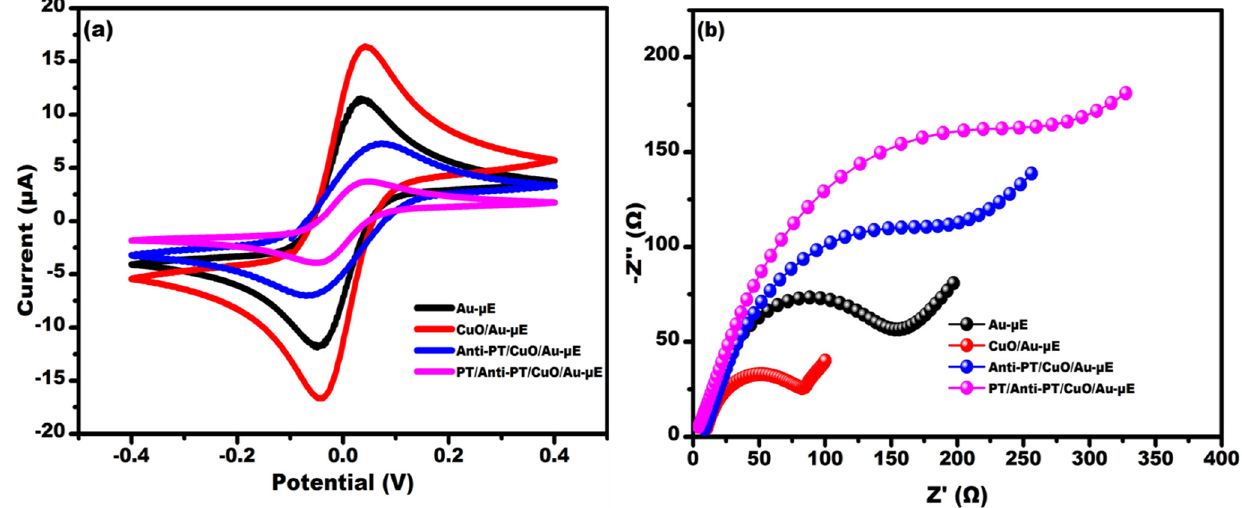
Figure 4. Electrochemical characterization of the fabricated sensor at each successive modification of electrode by ( a ) CV and ( b ) EIS.